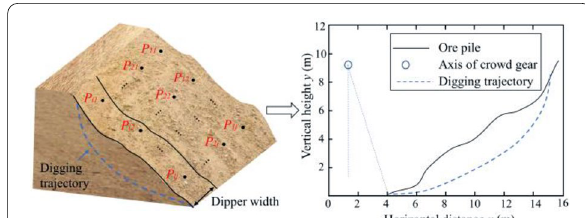
Figure 3 Constructing the ore pile surface